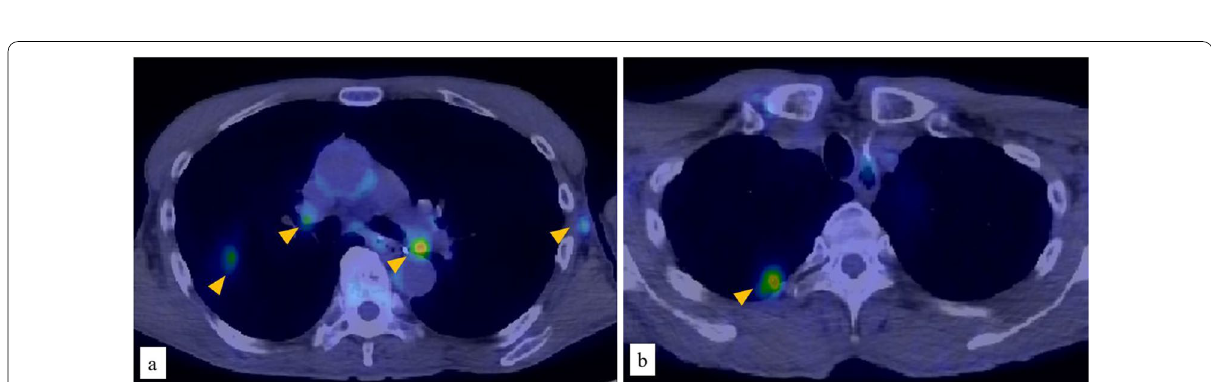
Fig. 3 Positron emission tomography–computed tomography imaging at the delayed phase, showing the diagnosis of multiple metastases. a Abnormal uptake in the subaortic, left hilar, and left axillary lymph nodes (arrow heads). b Abnormal uptake in a mass in the right lung apex (arrow